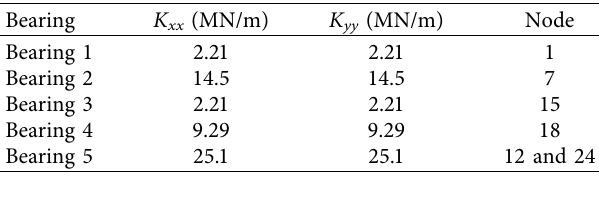
Table 4: Bearing properties for the rotor system.